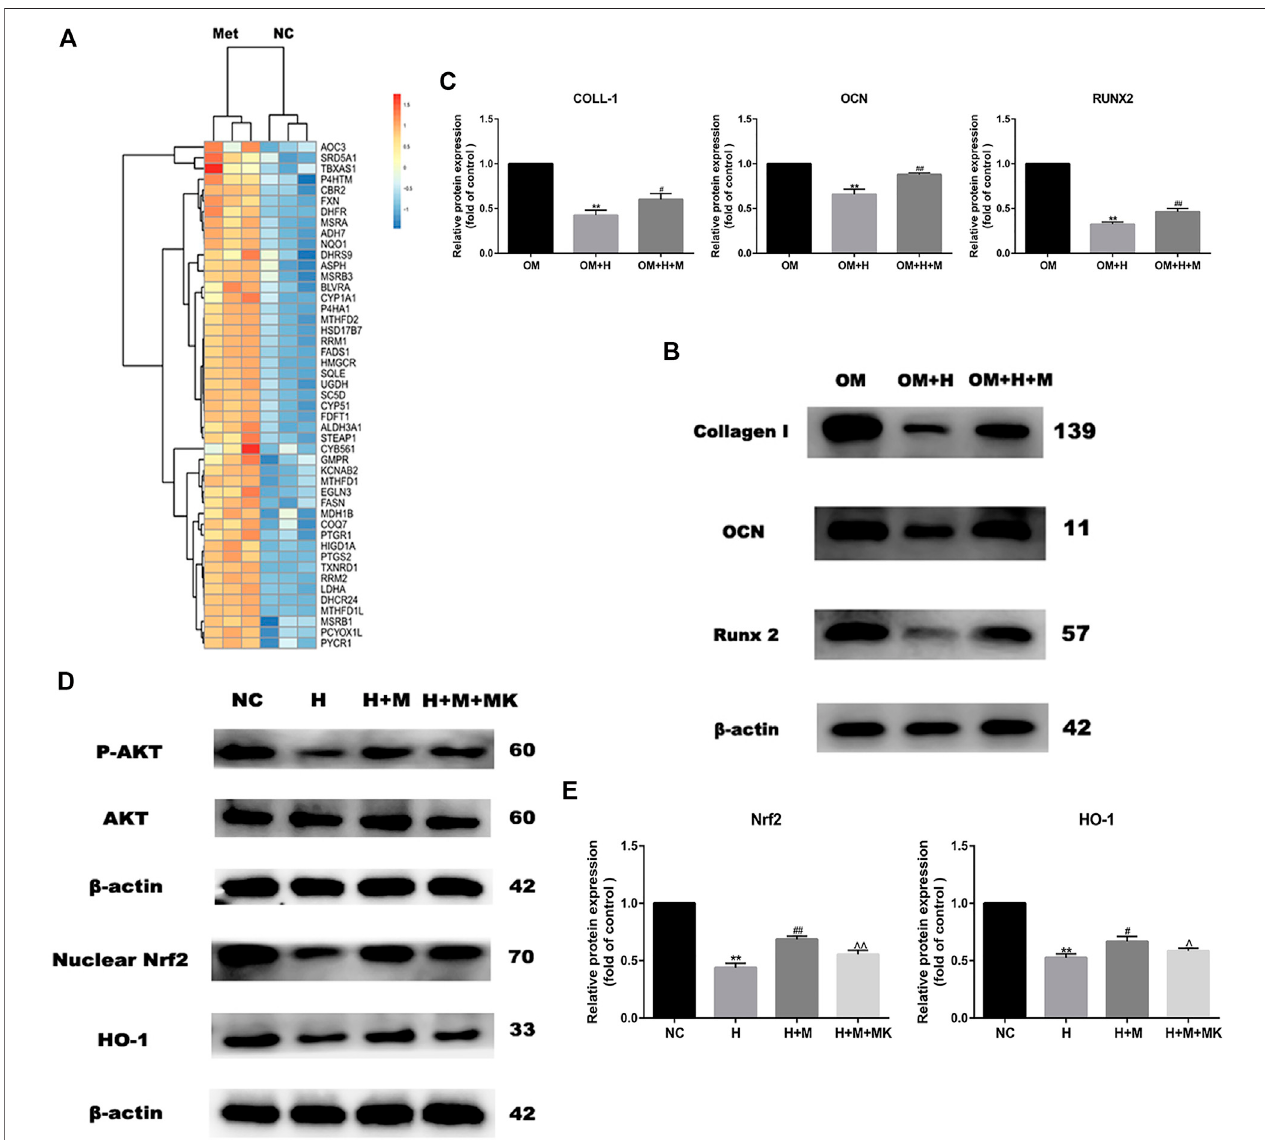
FIGURE 3| Metformin reserves H 2 O 2 -induced inhibition ofosteogenic differentiation. (A) Heatmap of up-regulated genesinvolved in oxidation-reduction reaction. (B) Protein expression of Collagen I, Runx 2 and OCN indicated the protective effect of metformin on H 2 O 2 inhibition (OM: osteogenic medium, OM + H: osteogenic mediumwithH 2 O 2 ,OM+H+M:osteogenicmediummixedwithH 2 O 2 andMK2206). (C) Relativeproteinexpressionleveloftheproteinsin (B) . (D) Proteinexpressionof p-AKT, nuclear Nrf2 and HO-1 after additing AKT inhibitor MK2206. (E) Relative protein expression level of the proteins in (D) . Experiments were implemented in triplicate. Dataaremeans±SD,* p < 0.05,** p < 0.01compared withcontrolcellsand # p < 0.05, ## p < 0.01compared withH 2 O 2 treatmentalone and ^ p < 0.05, ^^ p < 0.01 compared with combined treatment of H 2 O 2 and metformin analyzed by using